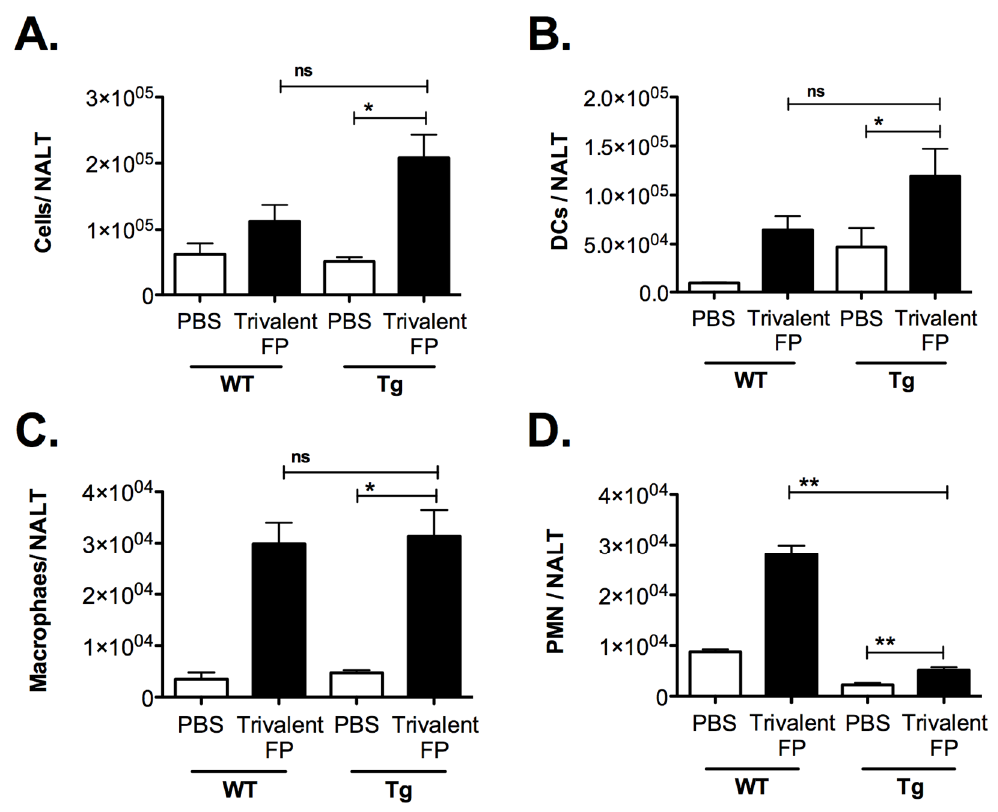
Figure 7. Trivalent-FP induced recruitment of leukocytes into the nasal-associated lymphoid tissue (NALT): groups of WT and Tg mice were immunized intranasally with PBS or Trivalent-FP. Two hours post-immunization, NALT cells were isolated and total cells were enumerated by microscopy ( A ). Subsequently, cells were stained with CD45-APC-Fire-750, CD11b-FITC, CD11c-APC, Gr1-Pacific blue, and F4 / 80- PE. CD45-positive cells were further evaluated, and DC (CD11c + ) ( B ), macrophages (CD11b + , F4 / 80 + ), ( C ) and PMN (Gr1 + , SSC high ), ( D ) were enumerated. Various cell populations were normalized to single cells, excluding doublets. Mean ± SE of data from two independent experiments is shown ( n = 6 / group, * p = 0.05, ** p = 0.01, ns = not significant). Statistical significance between indicated groups has been evaluated by Mann–Whitney nonparametric test.